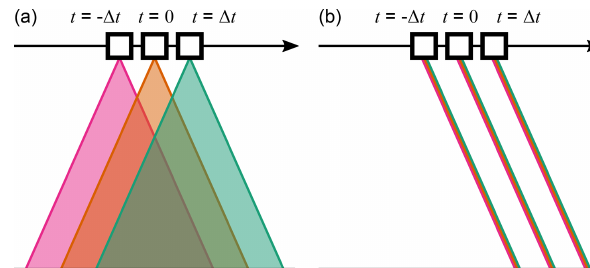
Figure 1. The schematic diagram of the field-of-view by the (a) 3MI and (b) SGLI. The black arrow shows the motion of the satellite along the orbit, and the three positions of the satellites along the track are shown to highlight asynchronous acquisition by the 3MI